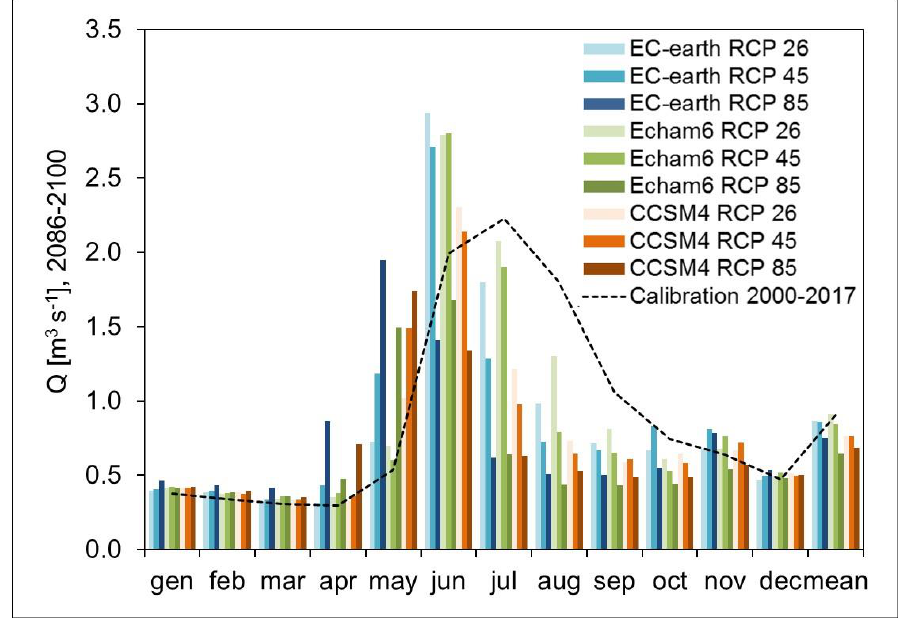
Figure 9. Sabbione catchment. Estimated mean monthly, and yearly mean discharge Q (m 3 s − 1 ). Control Run (2005–2017) and projected for period P2 (2086–2100).